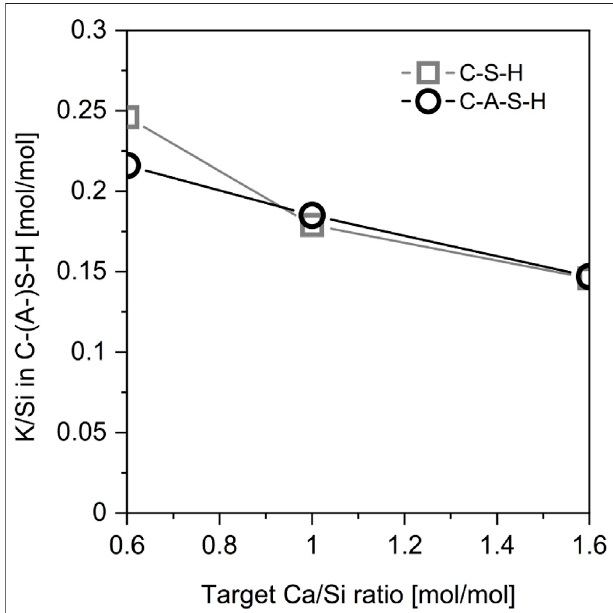
FIGURE 2 | Alkali uptake in C-S-H and C-A-S-H (Al/Si (cid:2) 0.05, Ca/Si (cid:2) 0.8) in equilibrium with a solution containing 0.5 mol/L [KOH] equilibrated for 182 days. Reproduced from (L ’ Hôpital et al.,